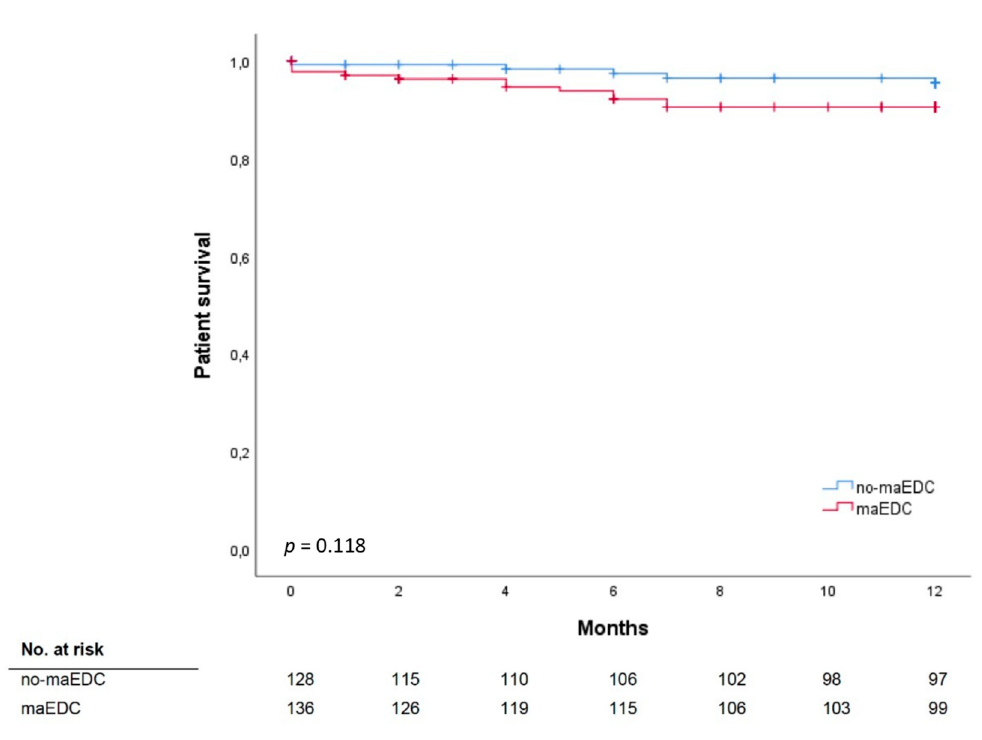
Figure 2. Patient survival does not significantly differ between recipients of no-maEDC and of maEDC grafts after censoring for mortality secondary to reasons other than graft failure-related complications (log-rank p = 0.118).